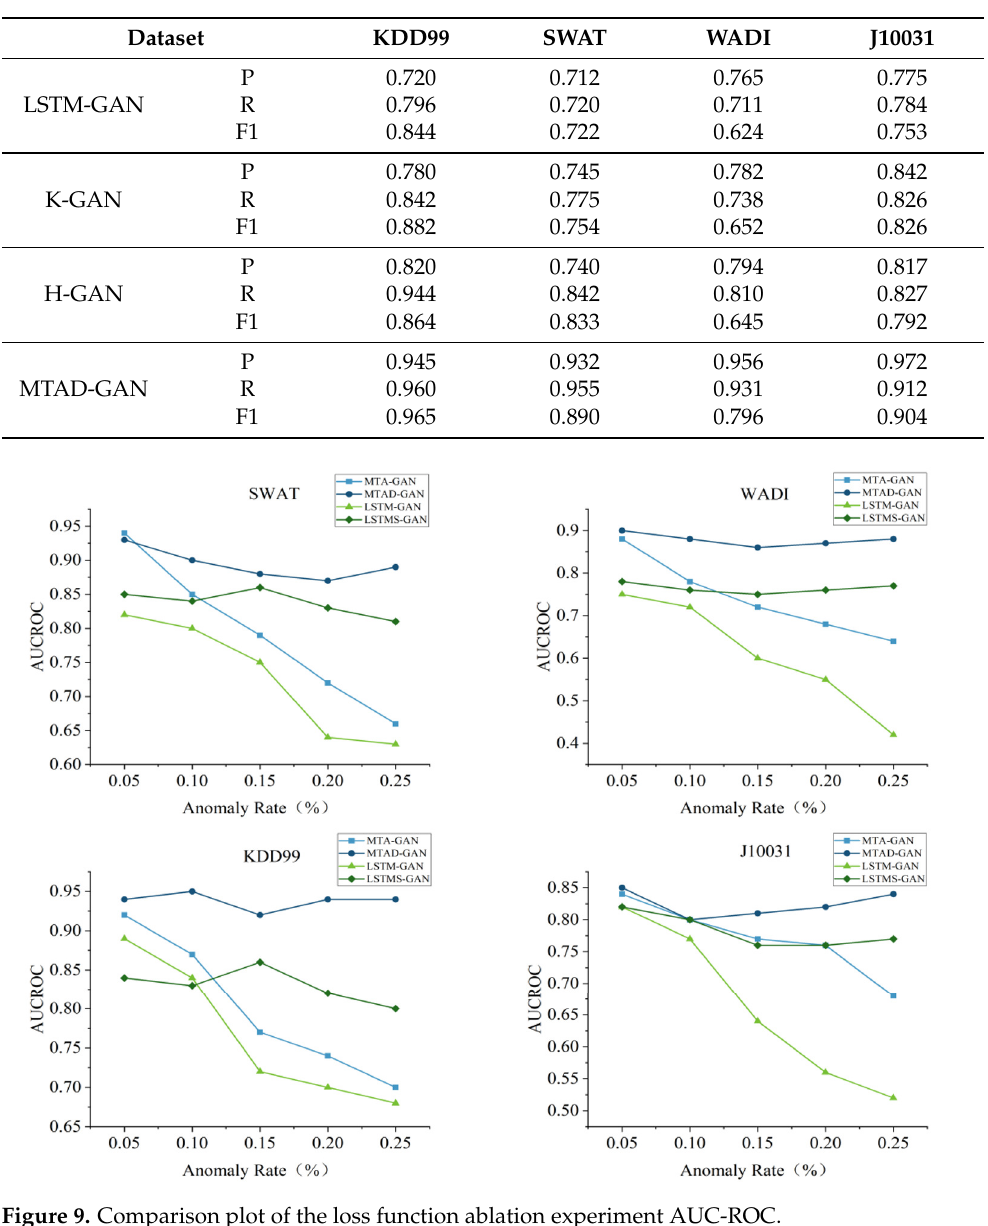
Table 7. Performance comparison of the P, R, F1 of ablation experiment.